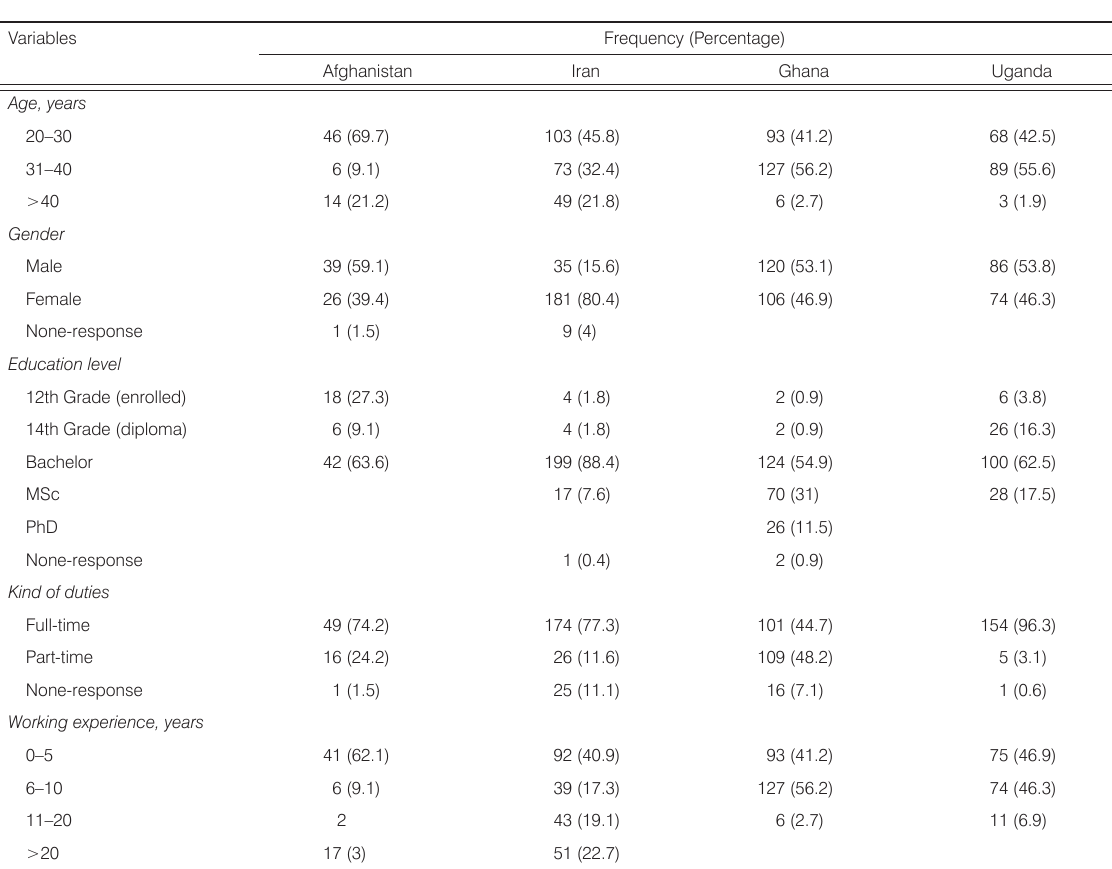
Table 1. Socio-demographic characteristics of the participants ( n = 677). Co-efficient